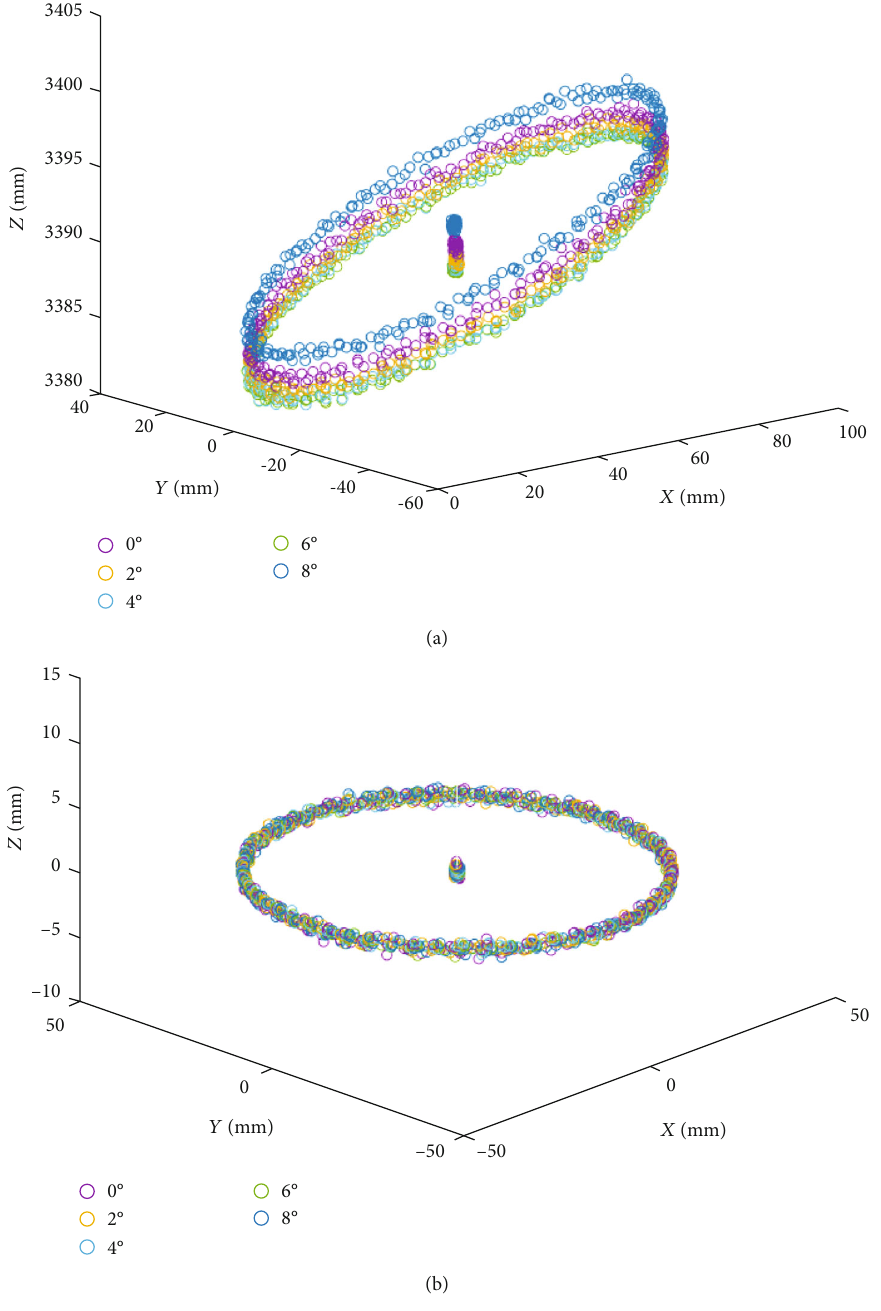
Figure 14: The measured positions of the hub targets in (a) the camera coordinate system and (b) the rotor coordinate